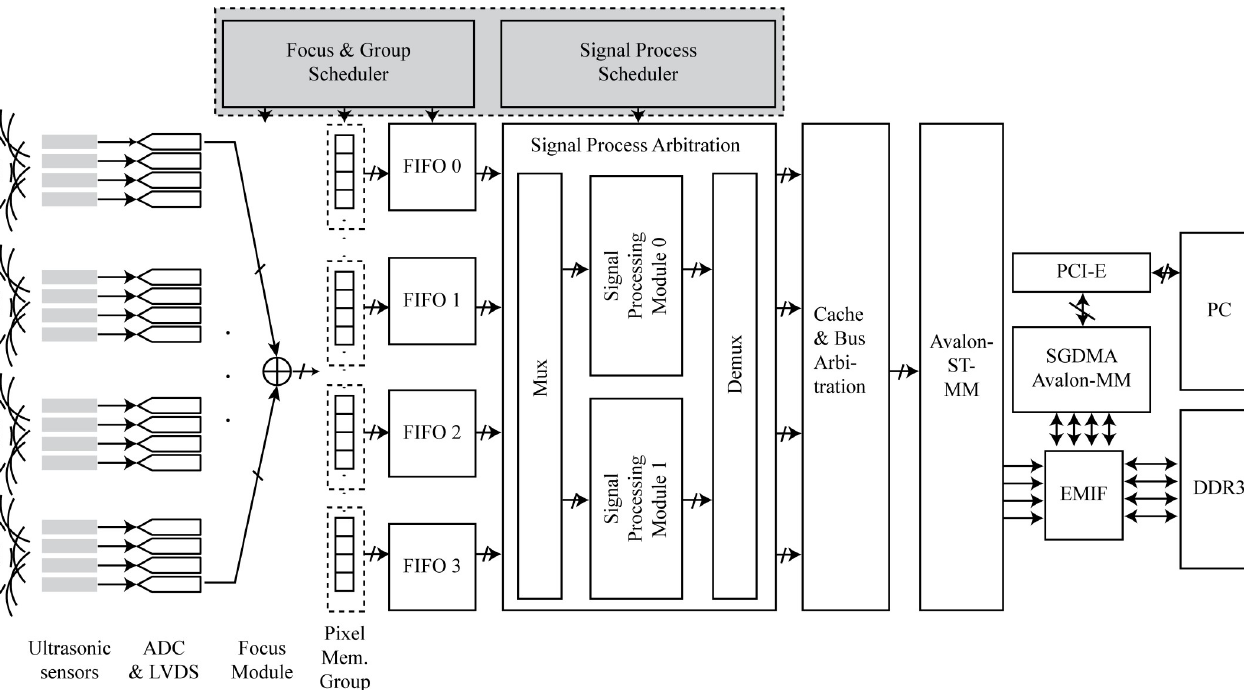
Fig 2. Architecture of asynchronous distributed ultrasound TFM